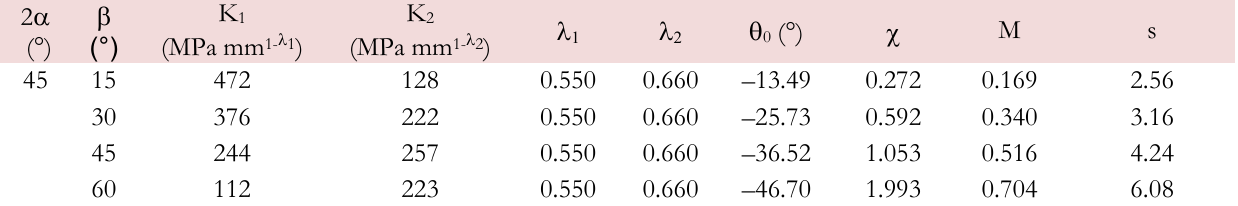
Table 1: Notch stress intensity factors K 1 and K 2 and crack propagation angle  0 for different mode ratios M resulting in support factors